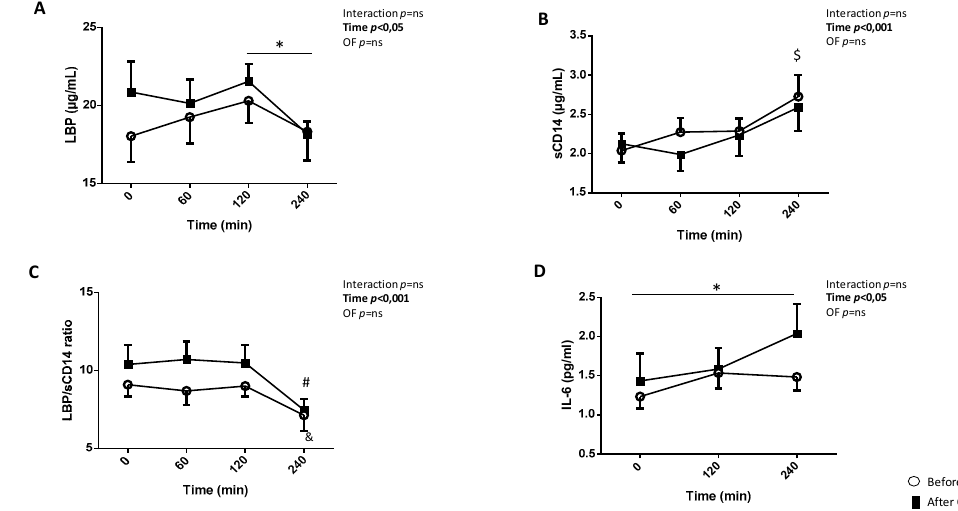
Figure 2. Postprandial kinetics of LBP ( A ), sCD14 ( B ), LBP/sCD14 ratio ( C ) and IL-6 ( D ) before and after overfeeding. Data are means ± SEM. The effects of time (postprandial kinetics) and overfeeding (OF) were determined by ANOVA for repeated measurements followed by post hoc test (Bonferroni). * p < 0.05 (after OF), & p < 0.05 vs. T0 and T120 (before OF); # p < 0.001 vs. other time (after OF); $ p < 0.05; 0.01; 0.001 vs. other time before and after OF.